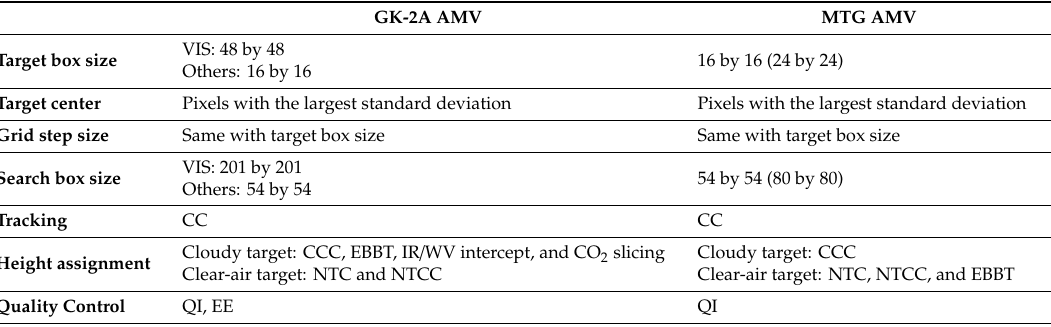
Table A1. Comparison of characteristics of GK-2A and MTG AMV